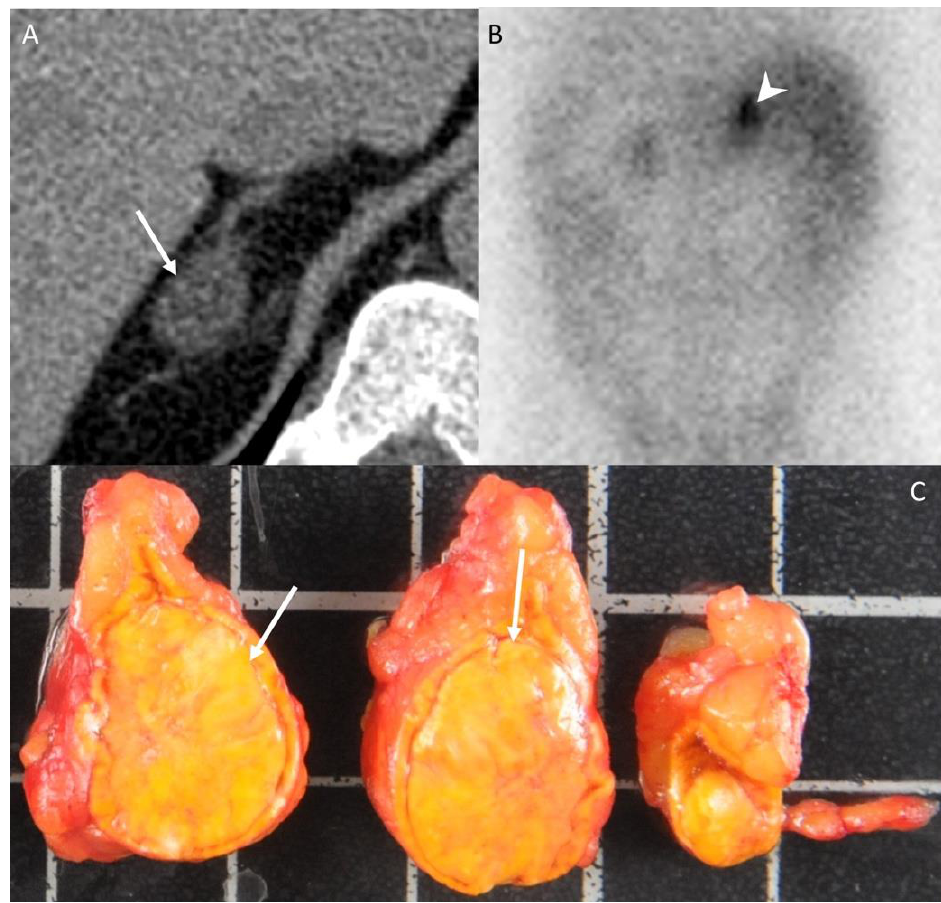
Figure 2. A 42-year-old woman without any medical history presenting with arterial hypertension. ( A ) Unenhanced CT image in the axial plane showing a 22-mm, homogeneous, right adrenal nodule (arrow) with an attenuation value of −6 HU, consistent with typical adrenal adenoma. ( B ) The 131I-iodo-cholesterol scintigraphy image in the posteroanterior projection shows a marked uptake of 131I-iodo-cholesterol by the right adrenal gland (arrowhead) consistent with a secreting adenoma. ( C ) Photograph showing the gross specimen after right adrenalectomy. Pathologic analysis confirmed a typical, homogeneous, well-encapsulated, benign adrenal adenoma (arrows) with a Weiss score of 0 and no other localization. The patients had no recurrence 10 years after the diagnosis. Each square in the background has a side of 1 cm.